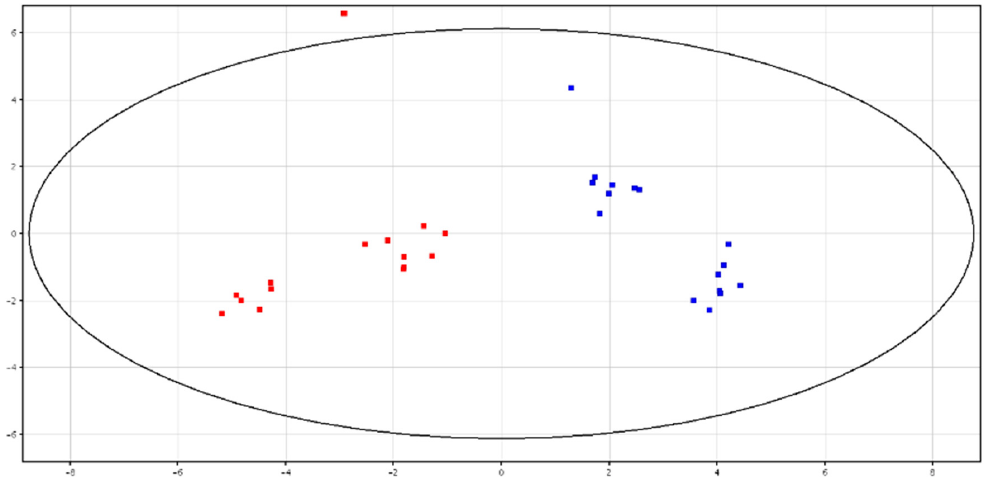
Figure 3. PCA scores plots of the LC–MS data acquired from fresh seminal plasma for high (in red; HF) and low (in blue; LF) fertility bulls. PC1 ( x -axis) is 43.77%; PC2 ( y -axis) is 21.53%.